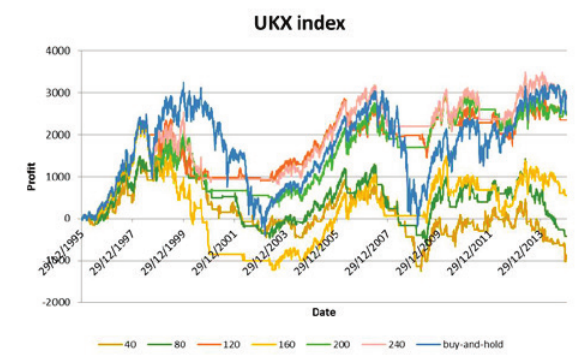
Figure 7. Profits of our strategy and “buy-and-hold” on HSI index (without transaction costs)